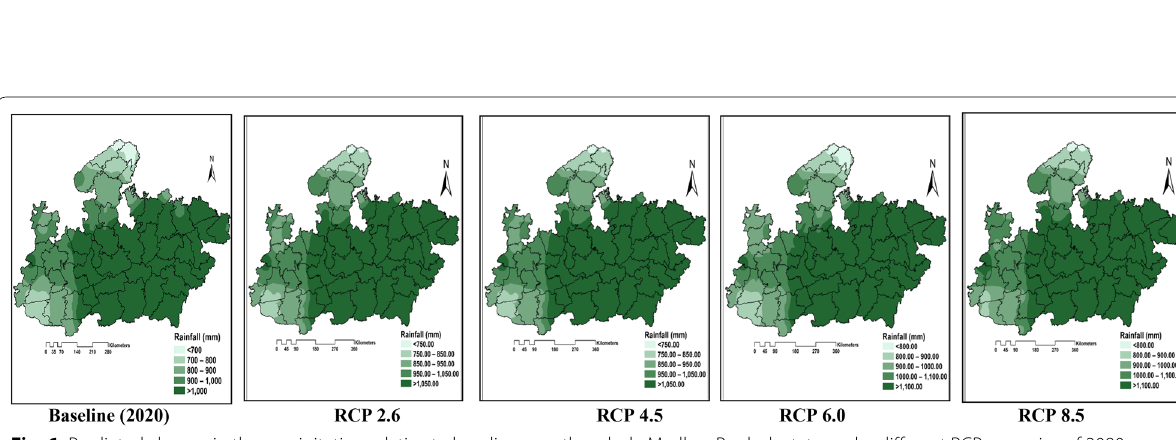
Fig. 6 Predicted change in the precipitation relative to baseline over the whole Madhya Pradesh state under different RCP scenarios of